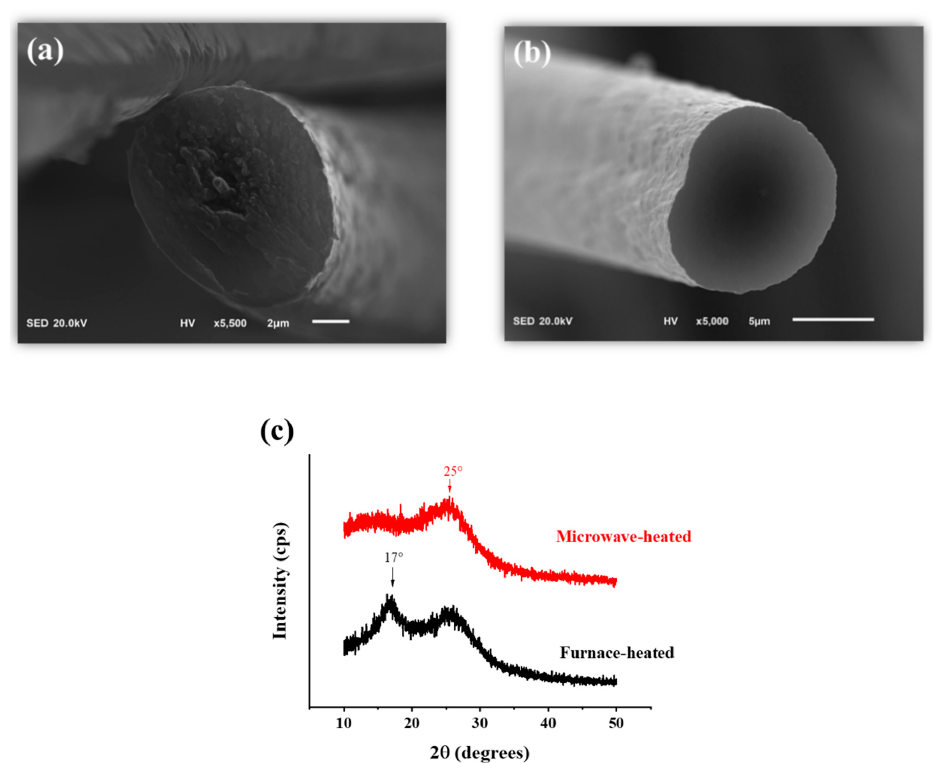
Figure 9. Comparison of furnace-heated and microwave-heated pre-oxidation specimens. ( a ) The cross-section area of the furnace-heated specimen. ( b ) The cross-section area of the microwave-heated specimen. ( c ) The XRD result reveals that the furnace-heated specimen still has a residual part of linear polymer structure.